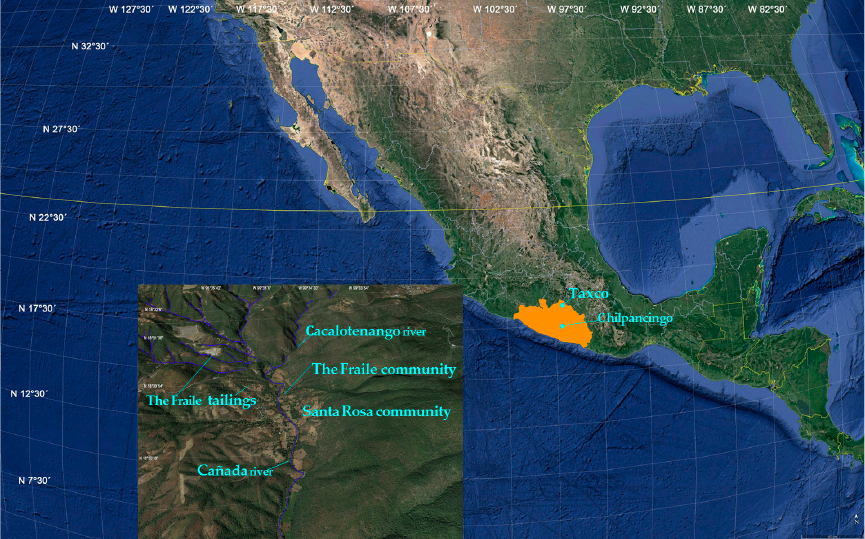
Figure 1. Study areas. The El Fraile community is located beside the El Fraile mine tailings in Taxco of Alarcon City in Northern, and Chilpancingo City in South, Guerrero State, México. of Alarcon City in Northern, and Chilpancingo City in South, Guerrero State, M é